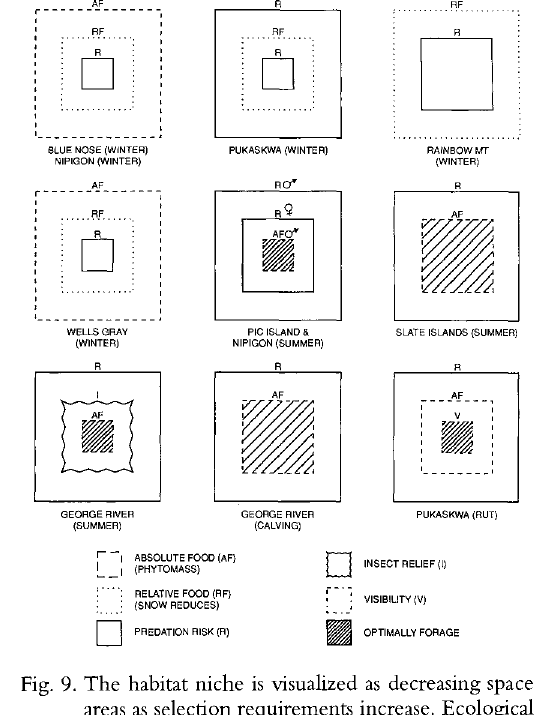
Fig. 9. The habitat niche is visualized as decreasing space areas as selection requirements increase. Ecological factors considered are food resources, snow depths, insect relief and predation risk. For exam ple the winter distribution of the Bluenose Herd (Carruthers et ah, 1986) is first determined by the absolute abundance of winter foods (animals will not winter where there is no food), within this area animals select areas of reduced snow cover (relative abundance of food) and within this area they select areas with reduced risk. The other niche presentations in the figure are based on my personal